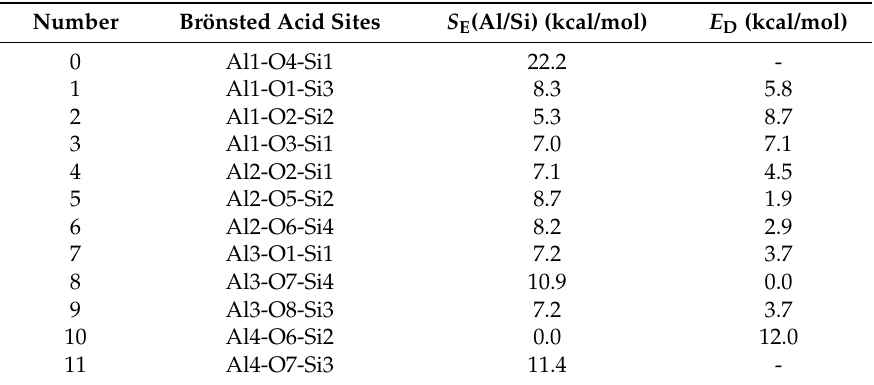
Table 1. S E (Al/Si) and E D of the different Brönsted acid sites of ferrierite (FER) zeolite. Number Brönsted Acid